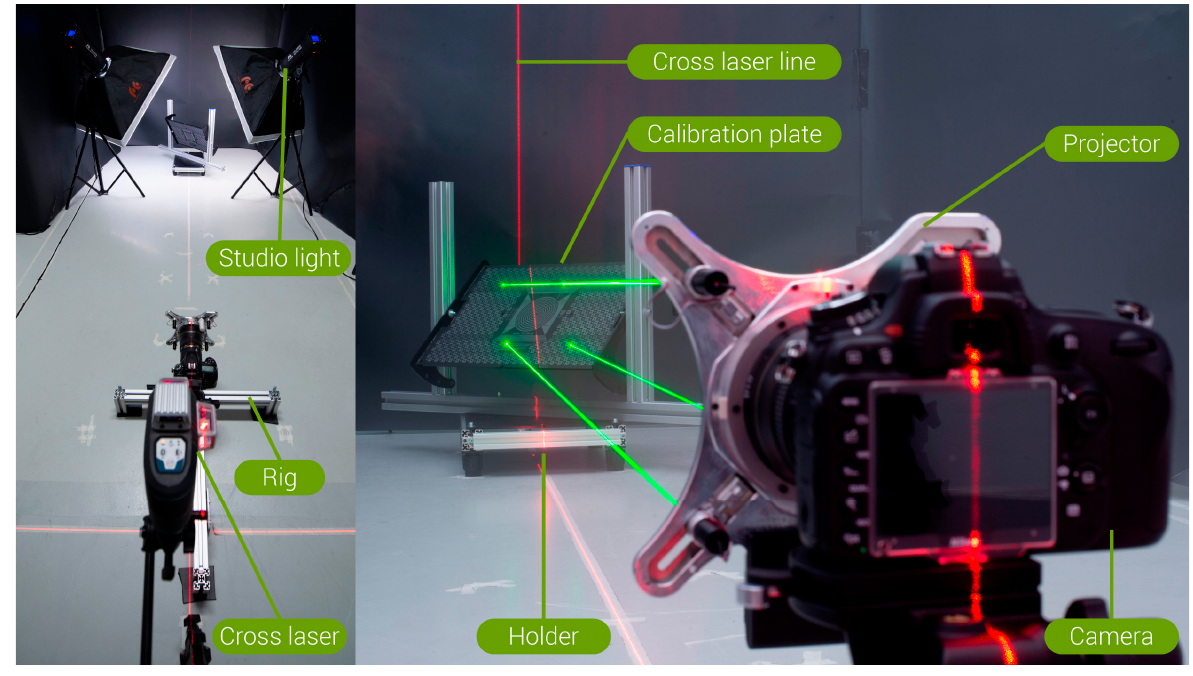
Figure 4. Test setup used to capture the photos for the verification tests: ( Left ) as viewed from behind and above the camera towards the calibration plate and ( Right ) as viewed from the left, behind and leveled with the